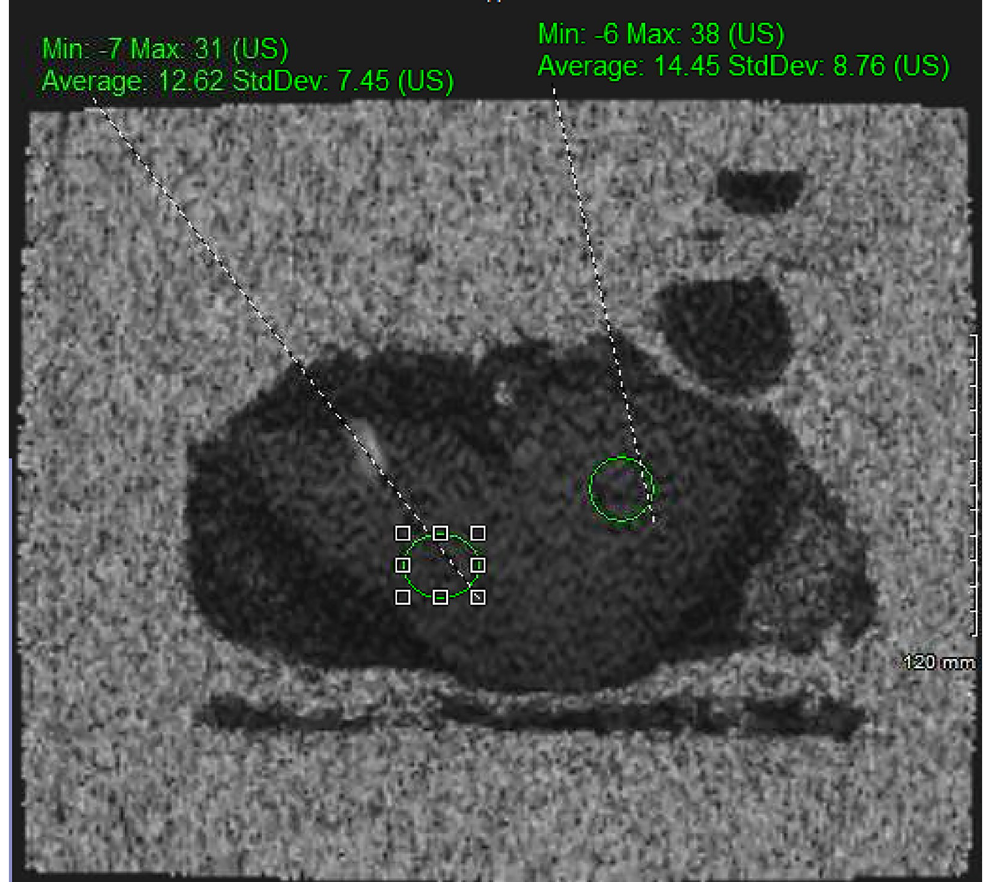
Fig 1. Representative T2 weighted images with the fat fraction map in region of interest (ROI) to delineate different segments.